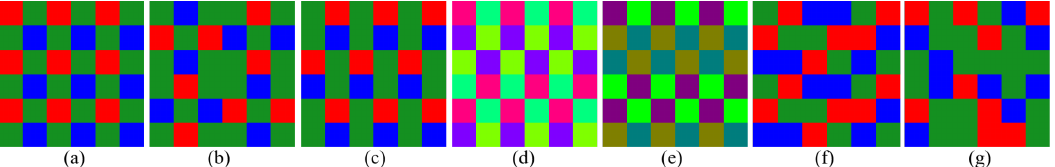
Figure 2. Different color filter arrays (CFAs): ( a ) Bayer CFA [26]; ( b ) Fuji X-Trans CFA [27]; ( c ) Lukac [23]; ( d ) Hirakawa Pattern-A [25]; ( e ) Hirakawa Pattern-B [25]; ( f ) proposed CFA (1:1:1); ( g ) proposed CFA